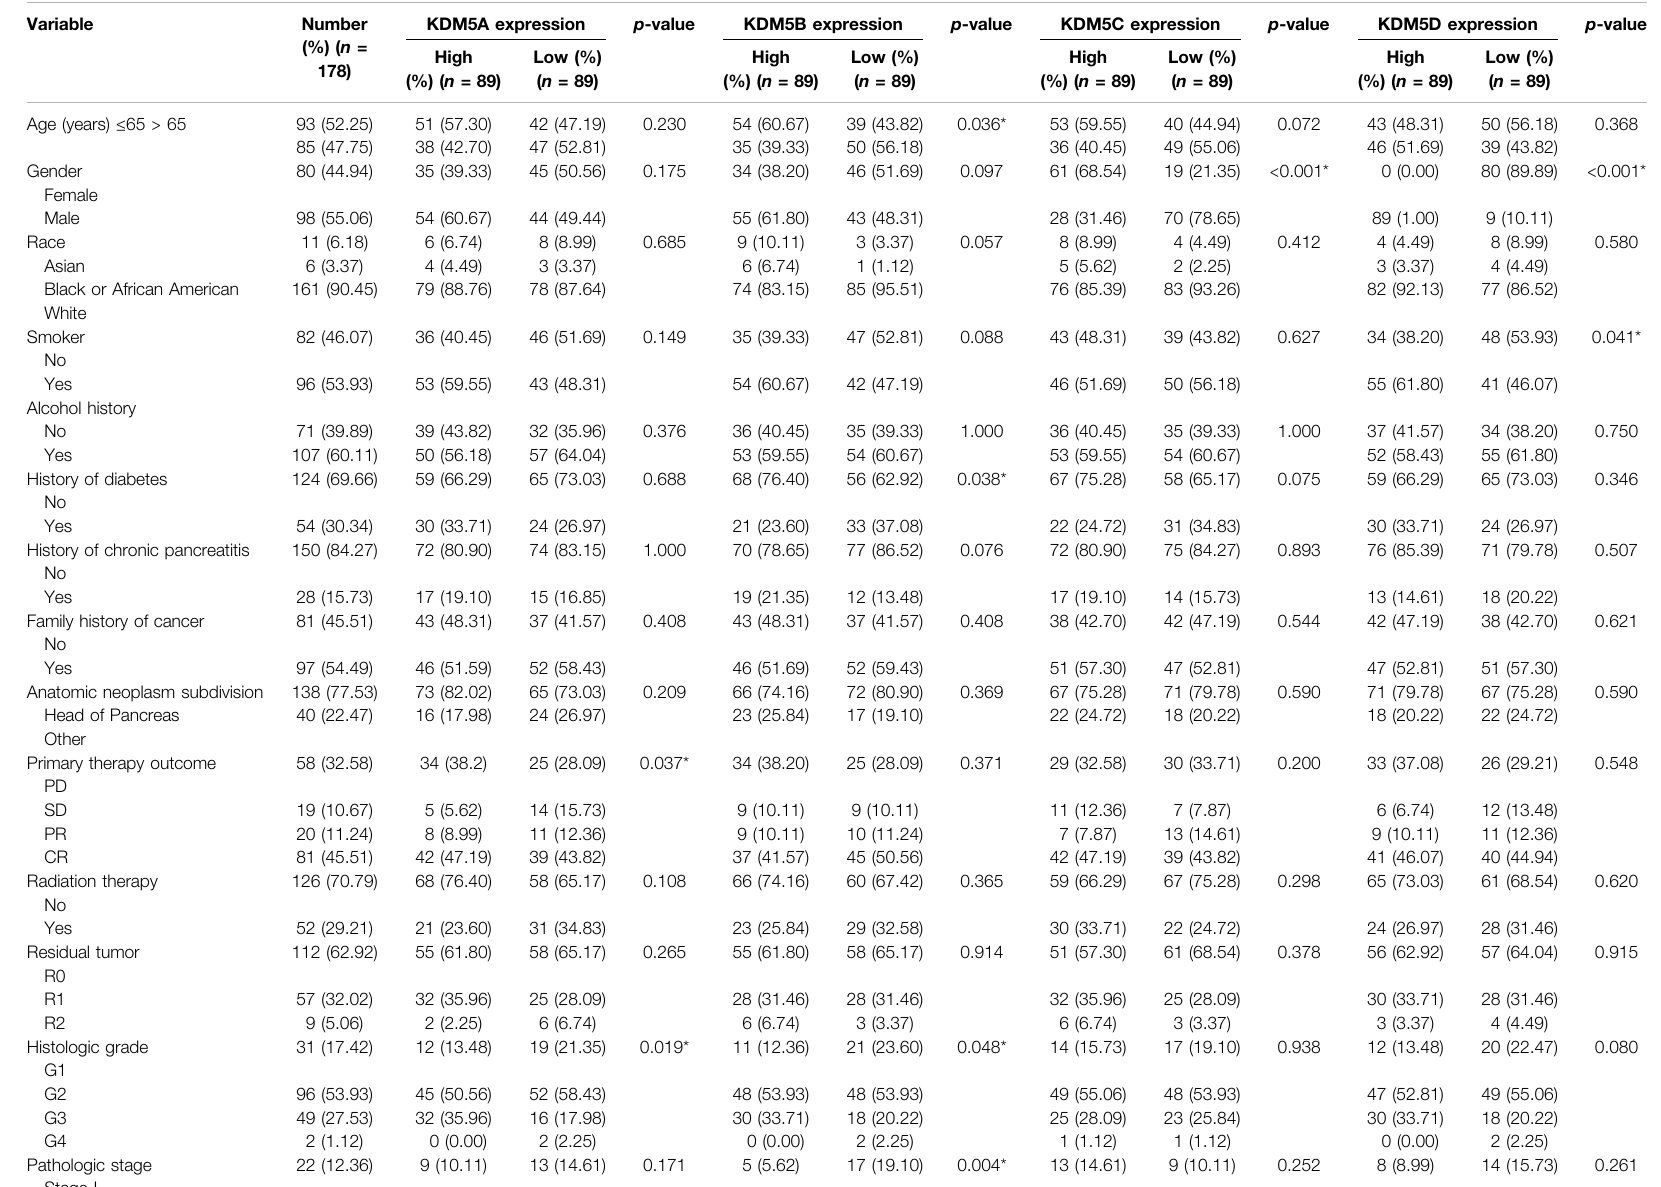
TABLE 1 | Relationship Between KDM5 family member expression and clinicopathological features in the PAAD cohort.